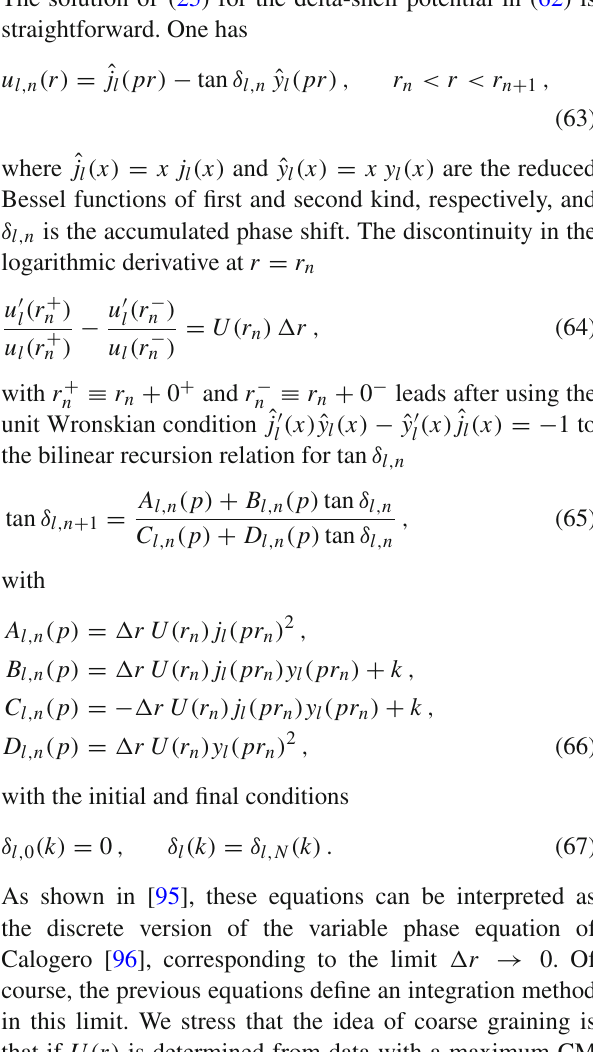
Fig. 5 Ratio of spectral regularized and unregularized TPE chiral potentials U I (cid:19) ( r )/ U I ( r ) for spectral cut-offs of (cid:19) = 1 . 4 GeV (solid, black), (cid:19) = 1 . 12 GeV (dotted, red) (cid:19) = 0 . 84 GeV (dashed, blue) at threshold and I = 2 (right)